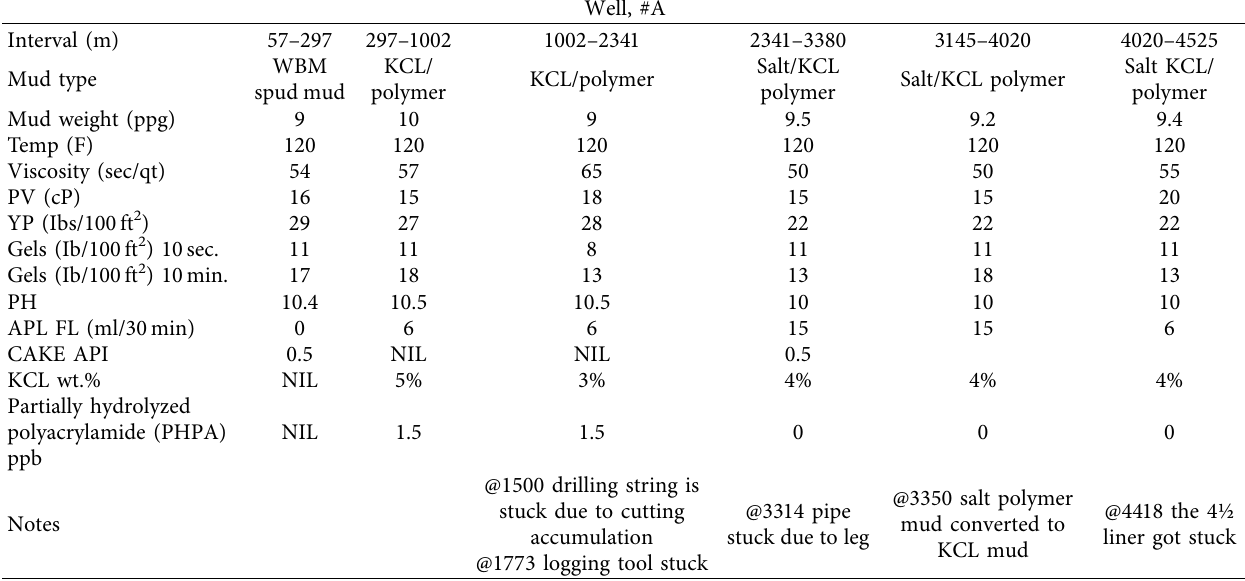
Table 3: Drilling mud design and properties.